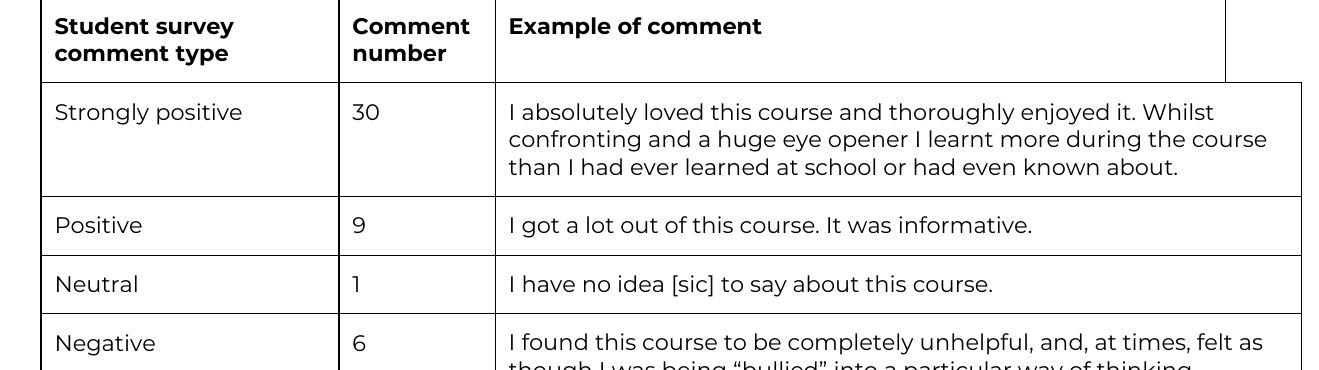
Table 2: Overview of comments Semester 1 2018 Student